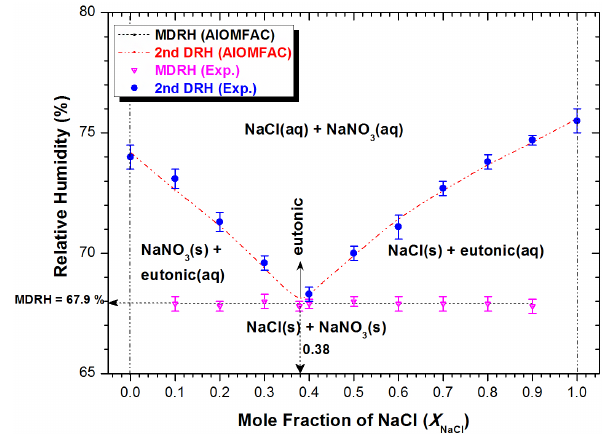
Figure 3. Measured first DRH or MDRH (open triangles), second DRH (closed circles) values, calculated MDRH (dotted line), and the second DRHs (dash-dotted curve) from the AIOMFAC, plotted as a function of the mole fraction of NaCl in NaCl–NaNO 3 mixture particles. The phase notations shown in brackets are s = solid; and aq =